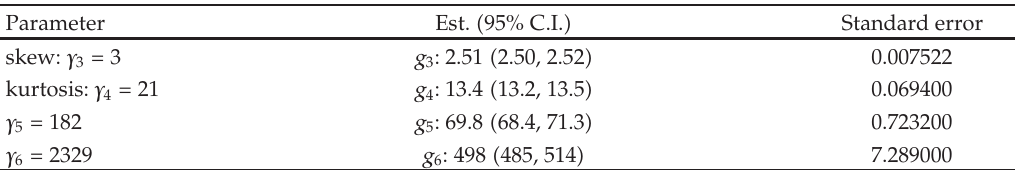
Figure 1: Standard normal-based power method pdf and cdf. The coe ffi cients used in (cid:2) 1.3 (cid:3) and (cid:2) 1.4 (cid:3) are c 1 (cid:7) − 0 . 252299, c 2 (cid:7) 0 . 418610, c 3 (cid:7) 0 . 252299, and c 4 (cid:7) 0 . 147593 and are associated with the parameters in Tables 1 and 2. Table 1: Conventional moment-based parameters (cid:2) γ (cid:3) and their estimates (cid:2) g (cid:3) for the pdf in Figure 1. Each estimate (cid:2) Est. (cid:3) , and bootstrap confidence interval (cid:2) C.I. (cid:3) was based on resampling 25,000 statistics. Each sample statistic was based on a sample size of n (cid:7)